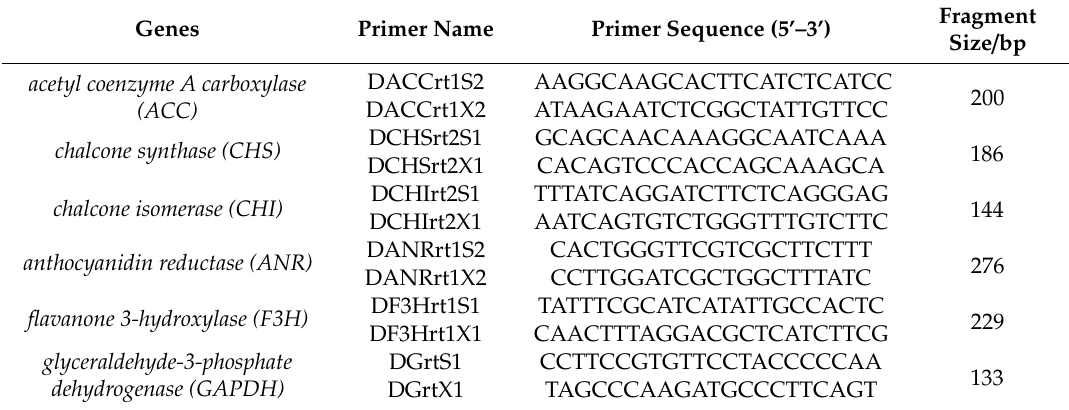
Table 2. Selected L. polystachyus partial gene sequences and qRT-PCR primer